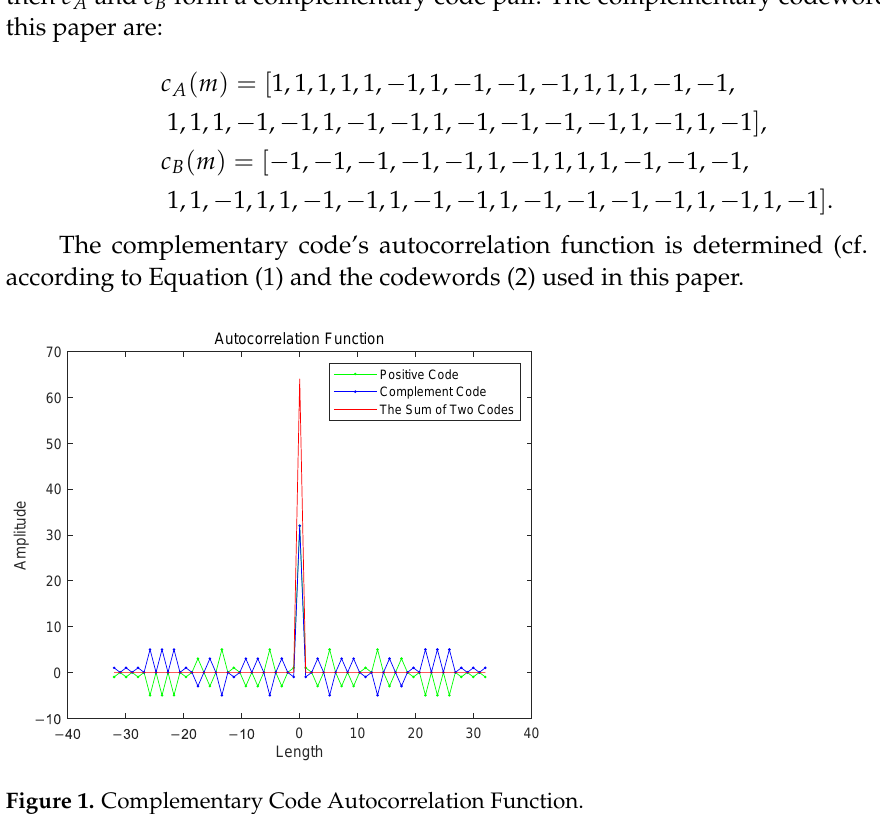
Figure 1. Complementary Code Autocorrelation Function.